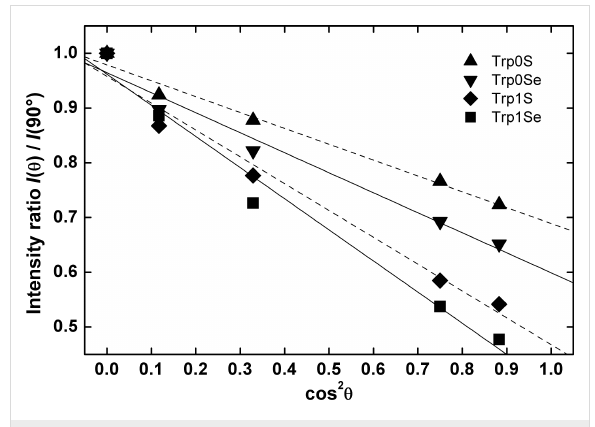
Au(111) dependencies on the square of the cosine of the incidence angle θ along with the least-squares fitting curves. The molecular tilt angles relative to the substrate surface normal as obtained by the fitting of the NEXAFS intensities are listed in Table 3.